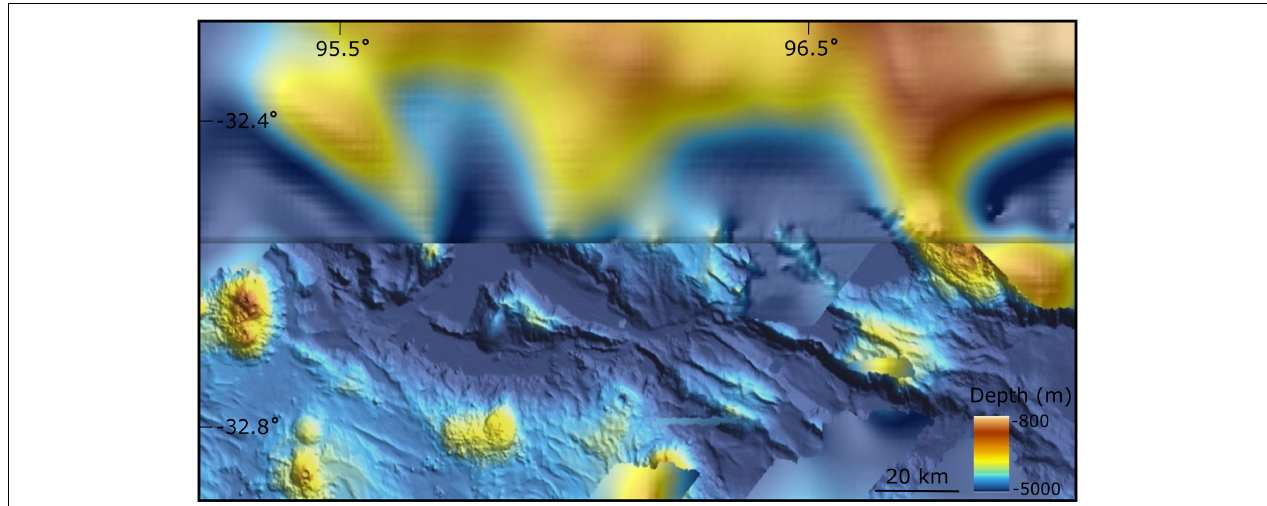
FIGURE 2 | Plan view of the Diamantina trench seafloor area in the Southeast Indian Ocean. The curtain image shows from top to bottom the data resolution increase between altimetry derived bathymetry data, sourced from the SRTM15_PLUS model (Olson et al., 2016), and multibeam bathymetry, gridded at 110 m horizontal resolution, that was acquired to assist the search for Malaysia Airline flight MH370. Image modified from the MH370 storymap (Australian Government,